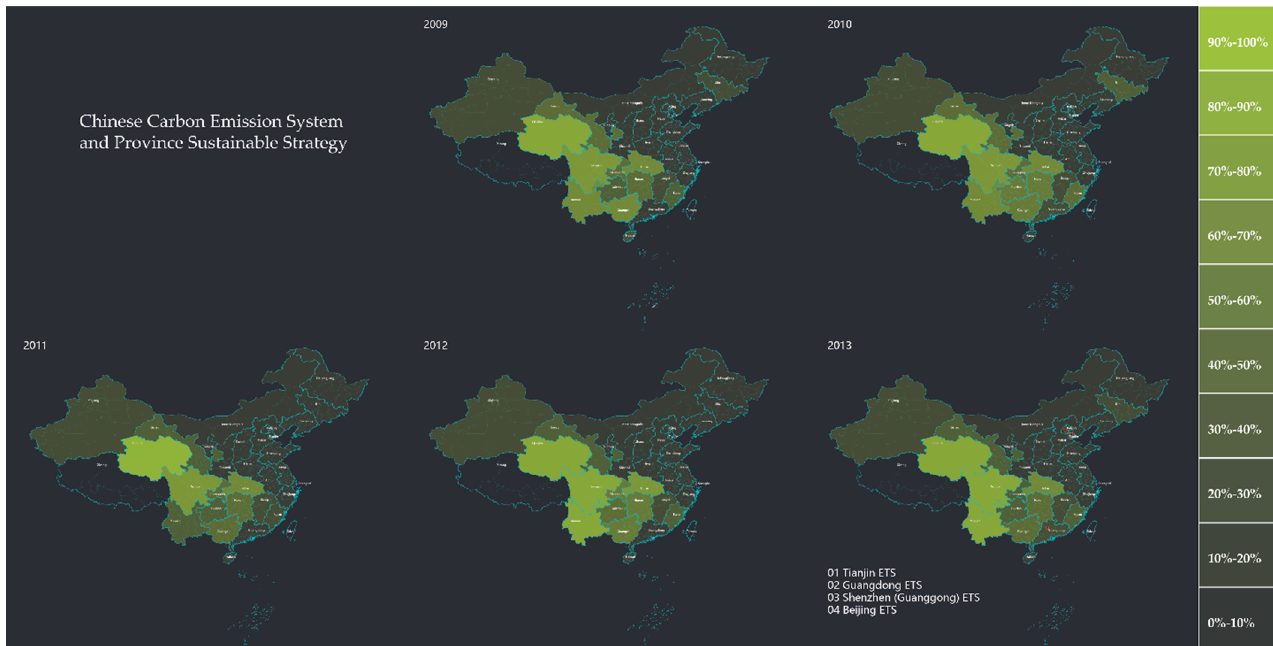
Figure 9. The SUB change across selected 30 provinces in China (2009–2011).